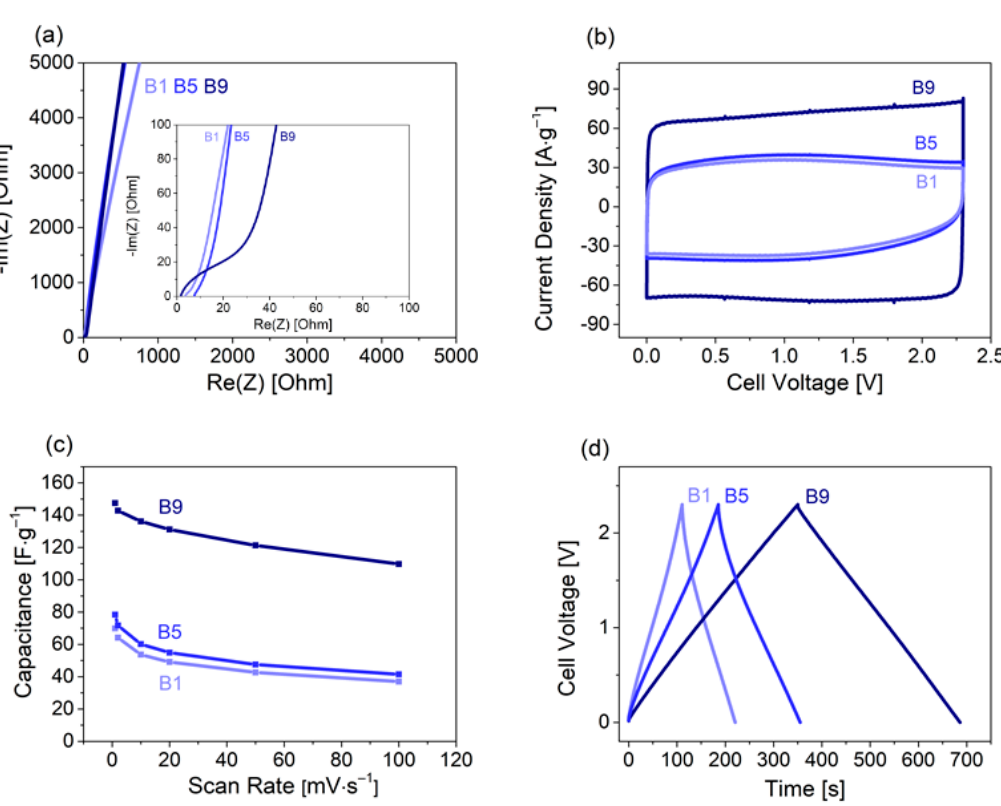
Figure 4. Electrochemical properties of all three manufactured activated willow bark samples, investigating ( a ) the impedance, ( b ) cyclic voltammetry (1 mV s − 1 ), ( c ) associated capacitance retention and ( d ) a galvanostatic cycle at 1.5 mA.